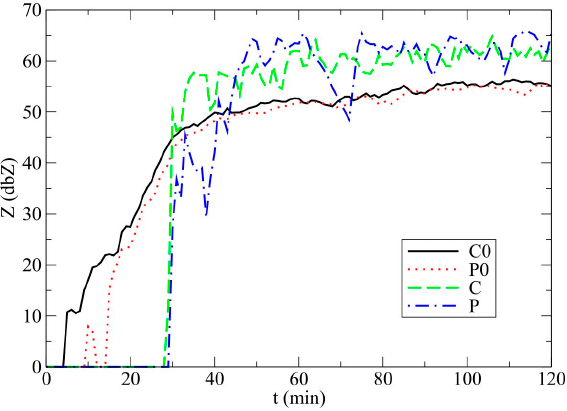
Figure 13. As in Figure 5, but for the the maximum values of radar reflectivity factor Z (dBZ).